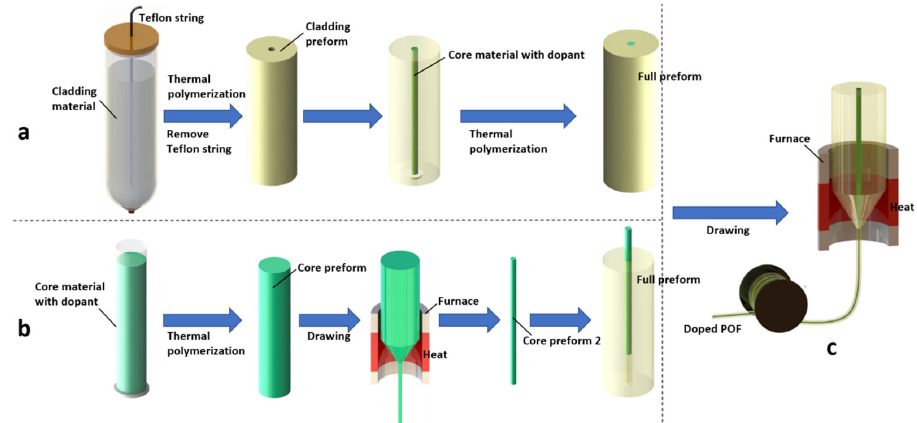
Figure 8. Schematic presentation of the fabrication processes of core ‐ doped fibers using double ‐ polymerization technique ( a ) [28,62] and pull ‐ through technique ( b ) [4,35], and the fiber drawing facility ( c ).